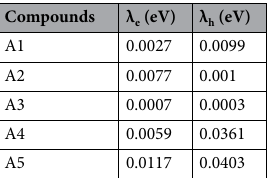
Table 5. Reorganizational energies of A1 – A5 at B3LYP 6-31G (d,p).